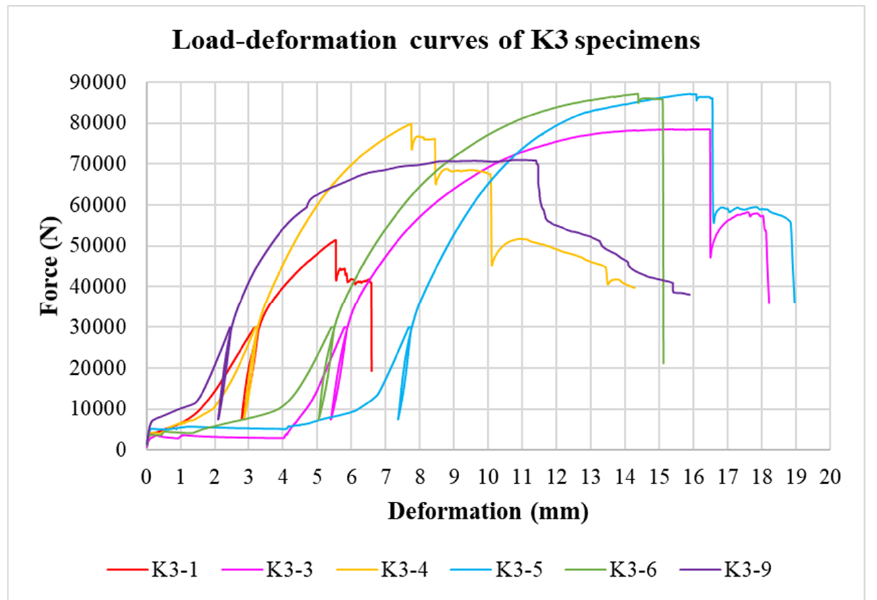
Figure 10. Load-deformation curves of K3 specimens. Table 4. Results of the experimental testing of K3 specimens.